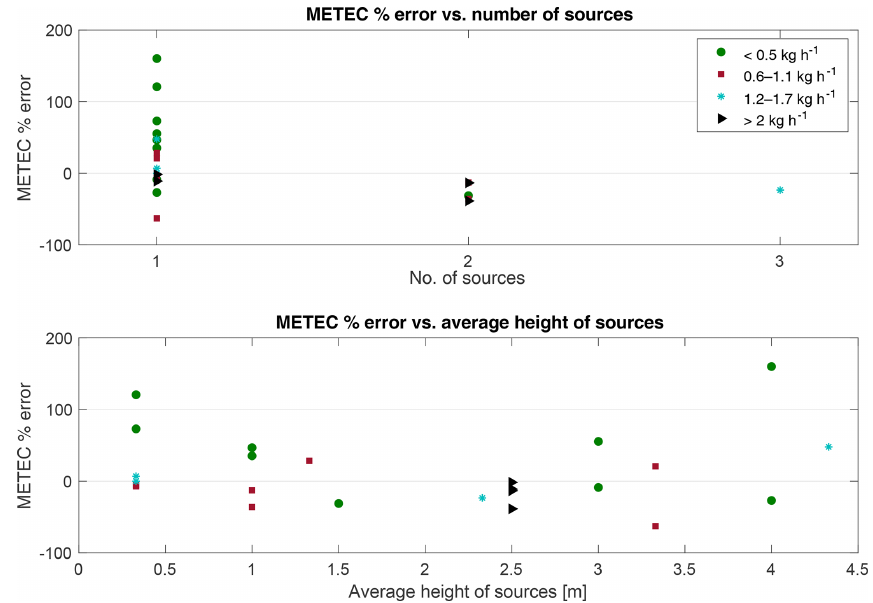
Figure 11. Percent error of the METEC-TR depending on source height or average height (for multiple sources). Positive error is OTM 33A overestimating the known release rate. Icons indicate the size bin of the known release